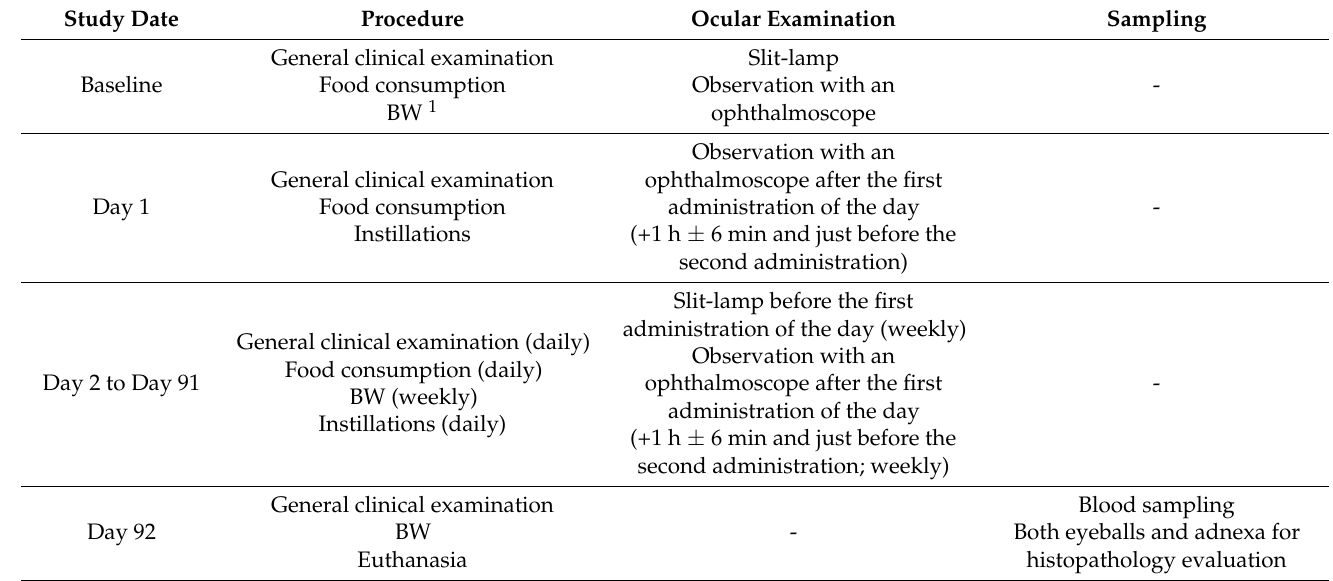
Table 1. Schedule table of procedures, ocular examinations and